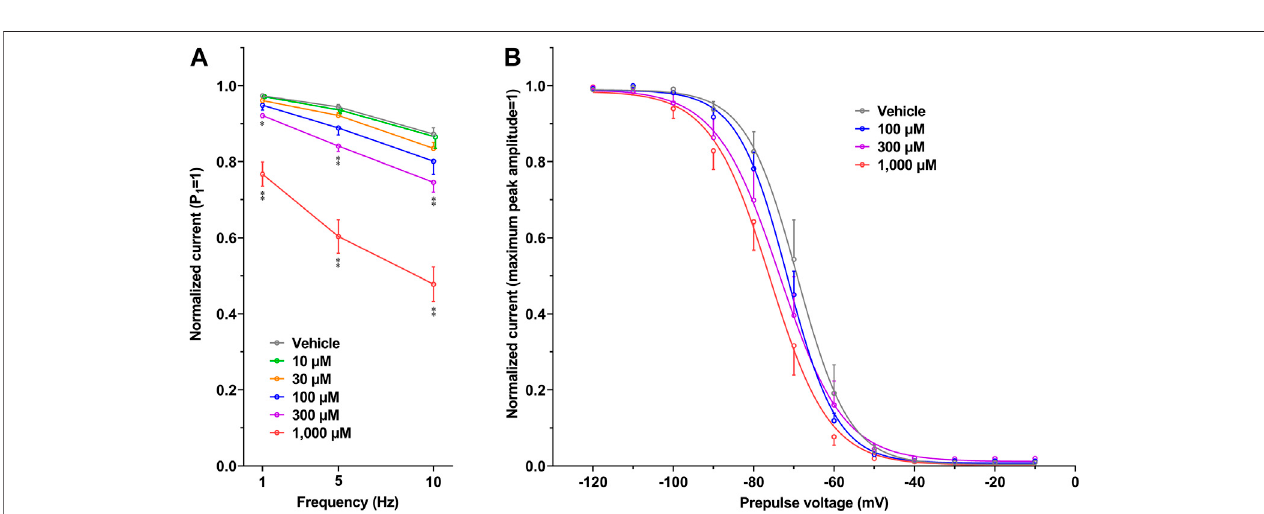
FIGURE 7 | Concentration-response curves showing the inhibitory action (%) of oseltamivir phosphate or vehicle (V) on Kir3.1/3.4, K V 1.5, hERG, Na V 1.5 and Ca V 1.2- derived currents. Data are presented as individual data (n (cid:1) 3 for Kir3.1/3.4 and K V 1.5-derived currents) or mean ± S.E.M. (n (cid:1) 6 for hERG, Na V 1.5 and Ca V 1.2-derived currents).Theconcentration-responsecurvesofKir3.1/3.4andhERG-derivedcurrentswere fi ttedwithHillequationwithsolidlineandtheirIC 50 valueswere160and231 μ M,